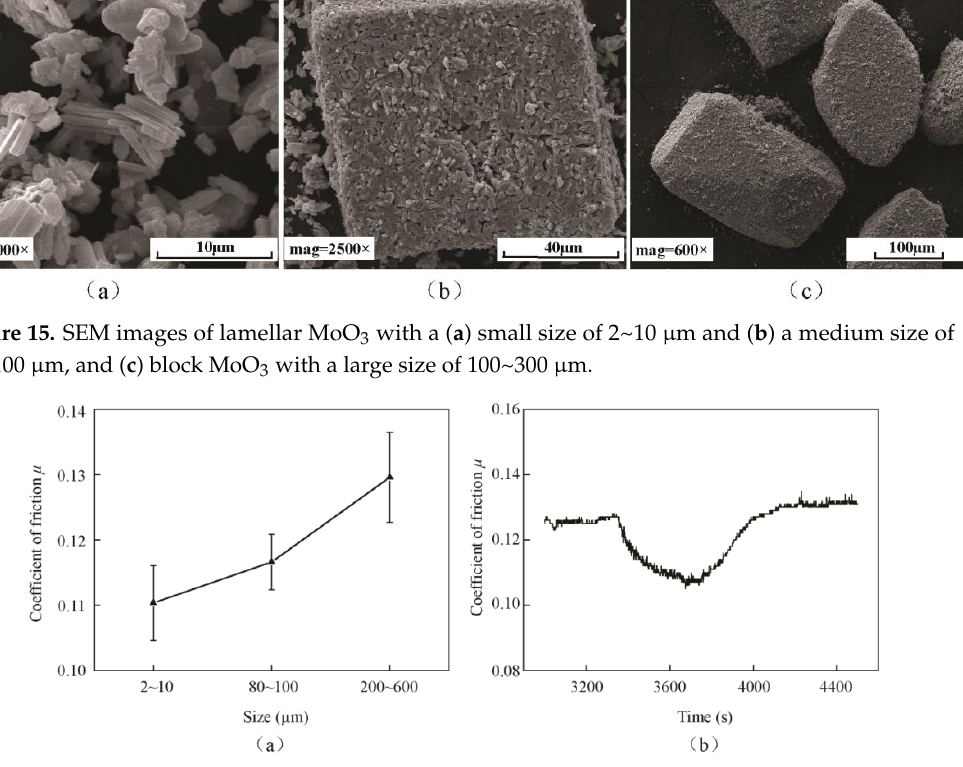
Figure 16. Friction coefficients of base oil with 0.5 wt % MoO 3 additives of different sizes: ( a ) average friction coefficients and ( b ) typical friction coefficient curve of medium-sized MoO 3 .